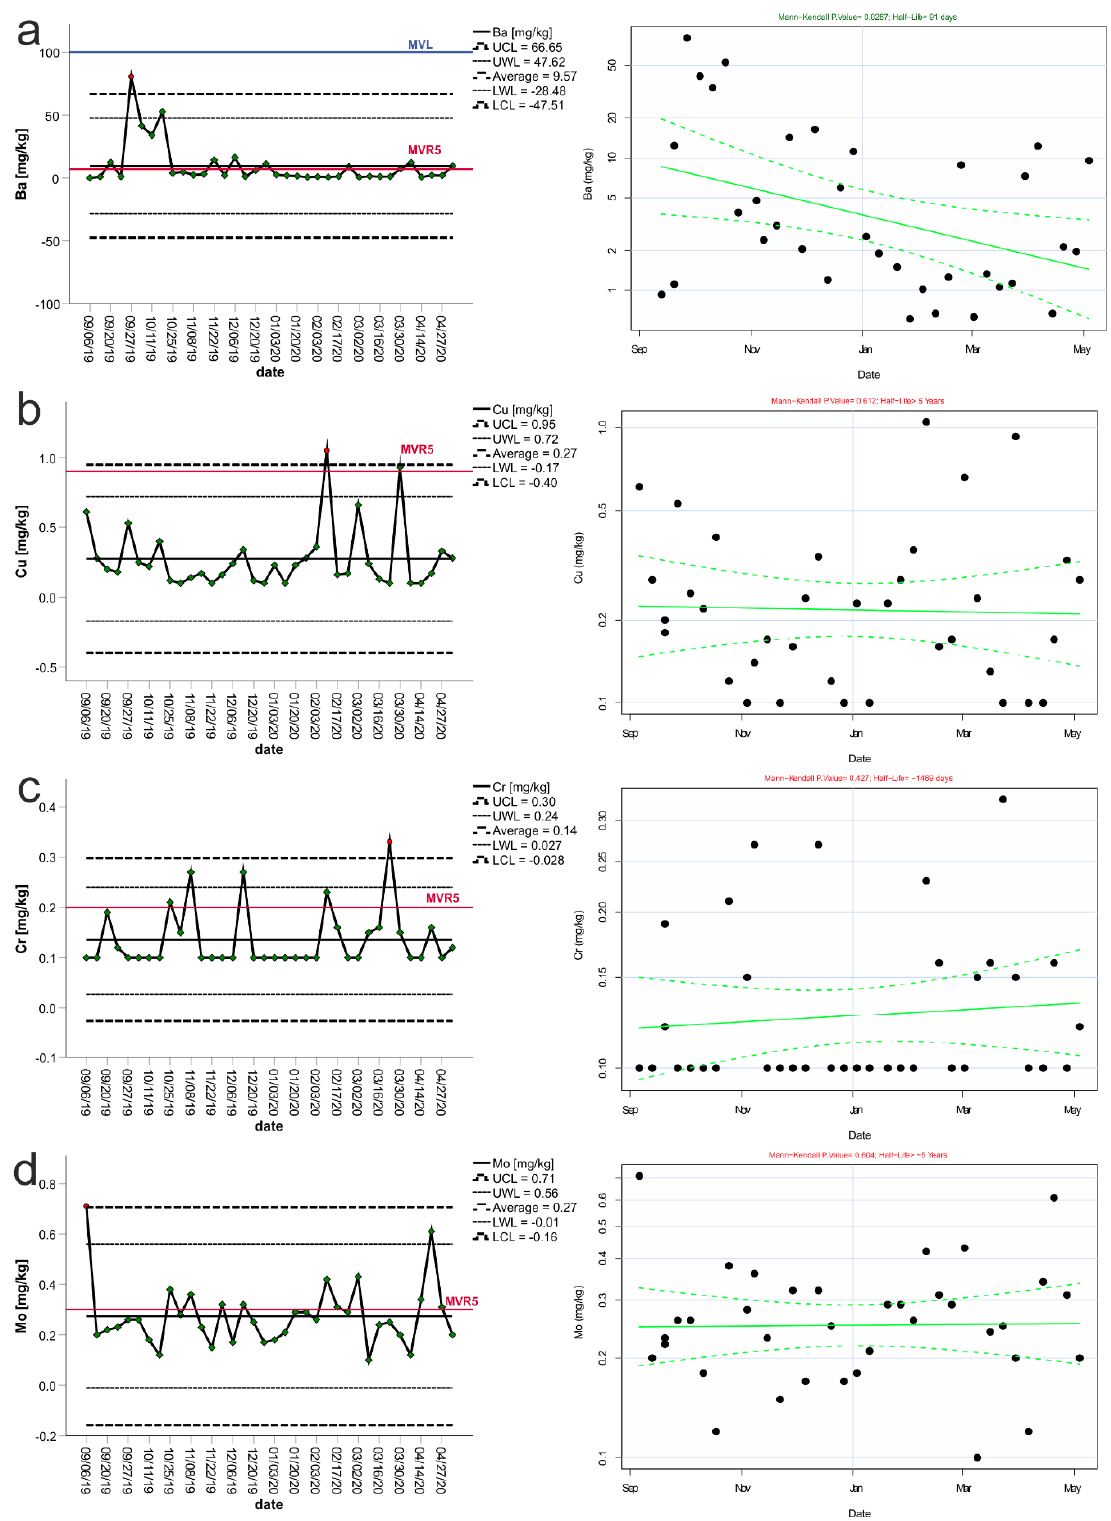
Figure 1. Control charts and trend analysis results for ( a ) Ba, ( b ) Cu, ( c ) Cr, and ( d ) Mo.